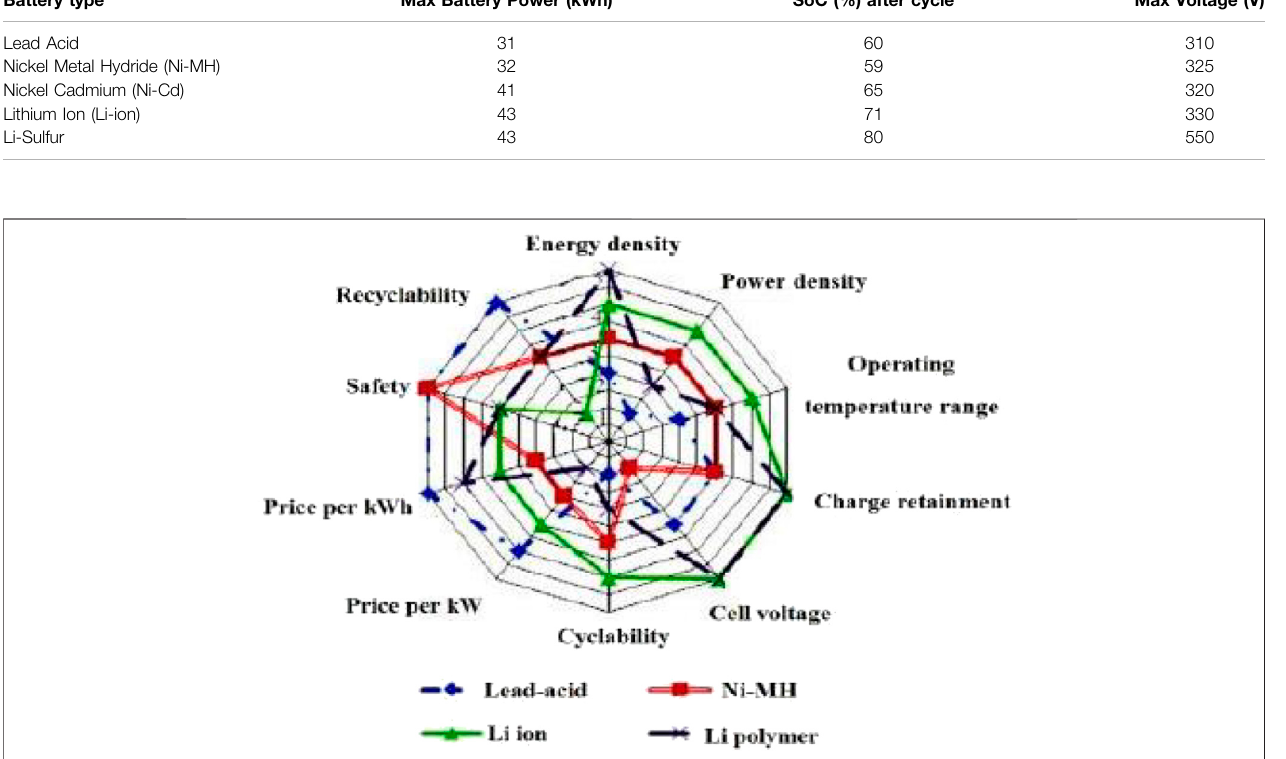
FIGURE 10 | Comparison of performance between four different batteries (Zhang et al.,